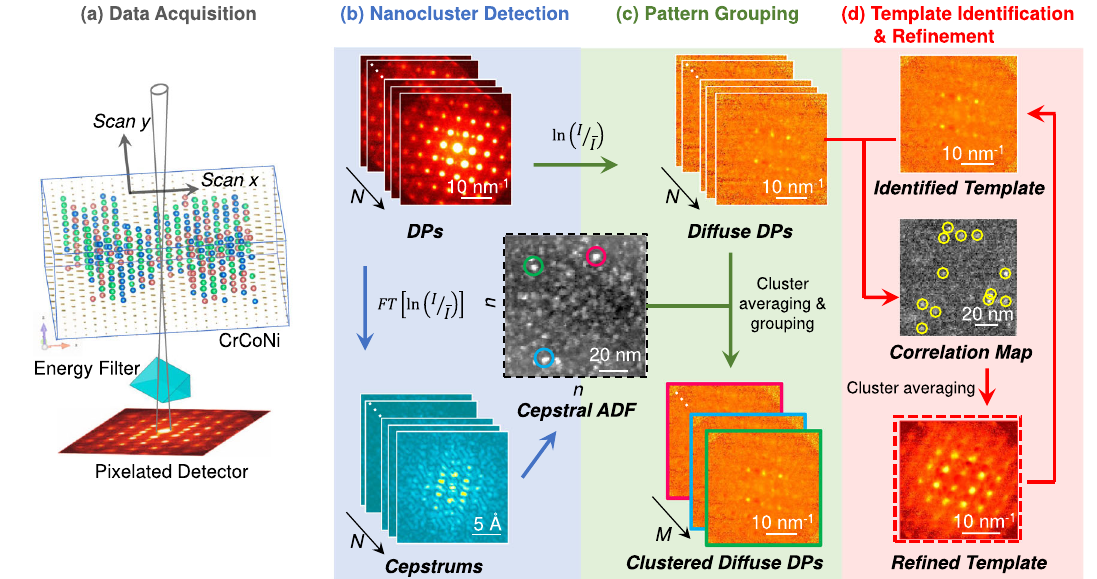
Fig.2|Dataminingofdiffractionpatterns(DPs)forCSROdetectioninCrCoNi. Four steps ( a – d ) are involved. a Data acquisition, energy- fi ltered diffraction pat- terns (DPs) in a scan are recorded using an ~1nm sized electron probe, with a pixelated detector. b The DPs are transformed into difference cepstra, which are then used to form cepstral annular dark- fi eld (ADF) images for nanocluster (NC) detection. c Bragg re fl ections are removed, using the log method, and diffuse DPs belonging to NCs are averaged and grouped together. d Diffuse DP templates are